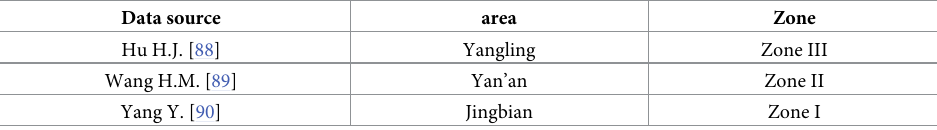
The value ranges of the VG model parameters, obtained by reading the contour graph in different zones, are shown in Table 5.